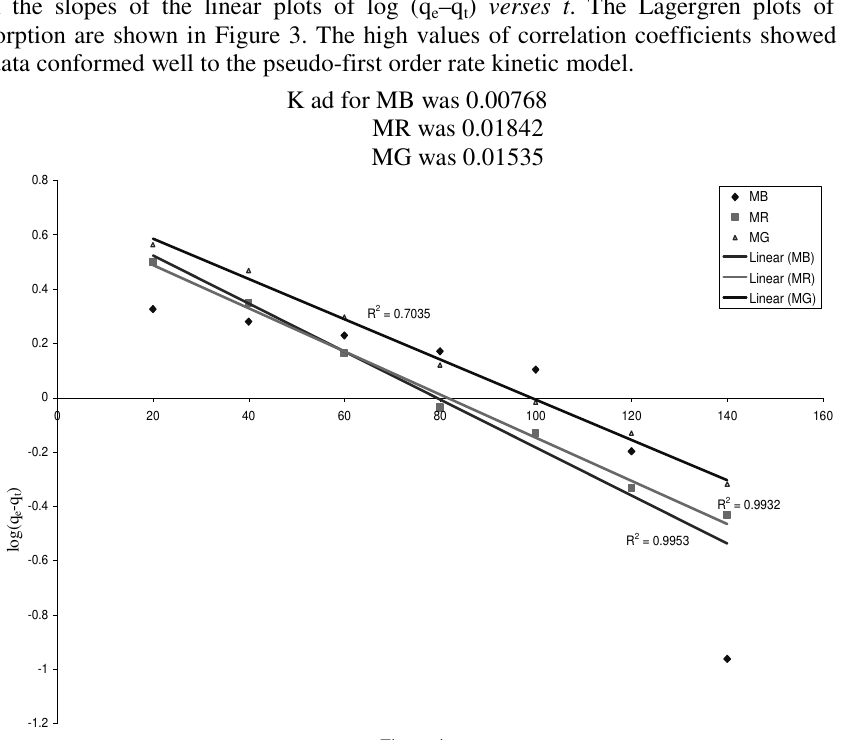
Time, Figure 3. Lagergren plots for biosorption of MB, MR, and MG by the mixtures of leafs, fruits and twigs of Muntangia calibura ( sorbent dose: 200 mg/50 mL; contact time: 3 h; pH: 6.0).